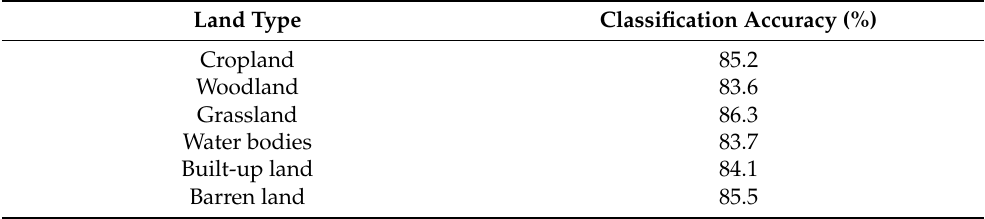
Table 1. Image classification accuracy